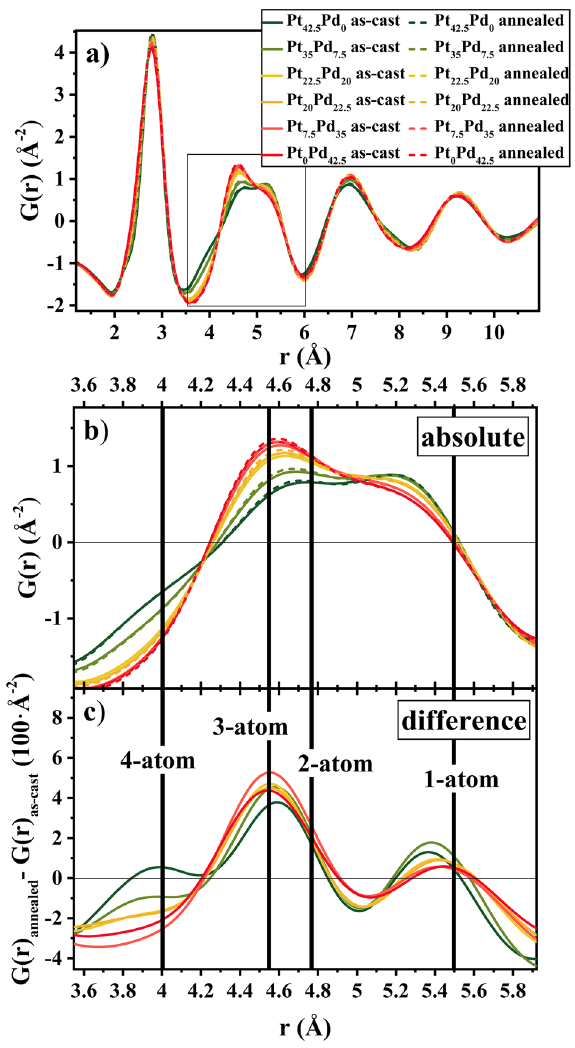
Figure 6. ( a ) The reduced pair distribution function G( r ) for Pt 42.5−x Pd x Cu 27 Ni 9.5 P 21 BMGs, where x = 0, 7.5, 20, 22.5, 35, and 42.5 at 298 K in the as-cast state (full lines) and after annealing for 24 h at T g -50 K (dashed lines). ( b ) Magnified view of the box in a), featuring the second peak of G(r) for all alloys in annealed and as-cast state. The second peak of G(r) corresponds to the second nearest neighbor distances, therefore bearing information of the cluster connection schemes. ( c ) Difference in the reduced pair distribution function between annealed and as-cast state. A large change on the length scale of 4.55 Å is seen, corresponding to a distance of √ 8 / 3 r 1. The vertical lines in ( b ) and ( c ) represent the most likely second nearest neighbor distances if adjacent clusters share one (2